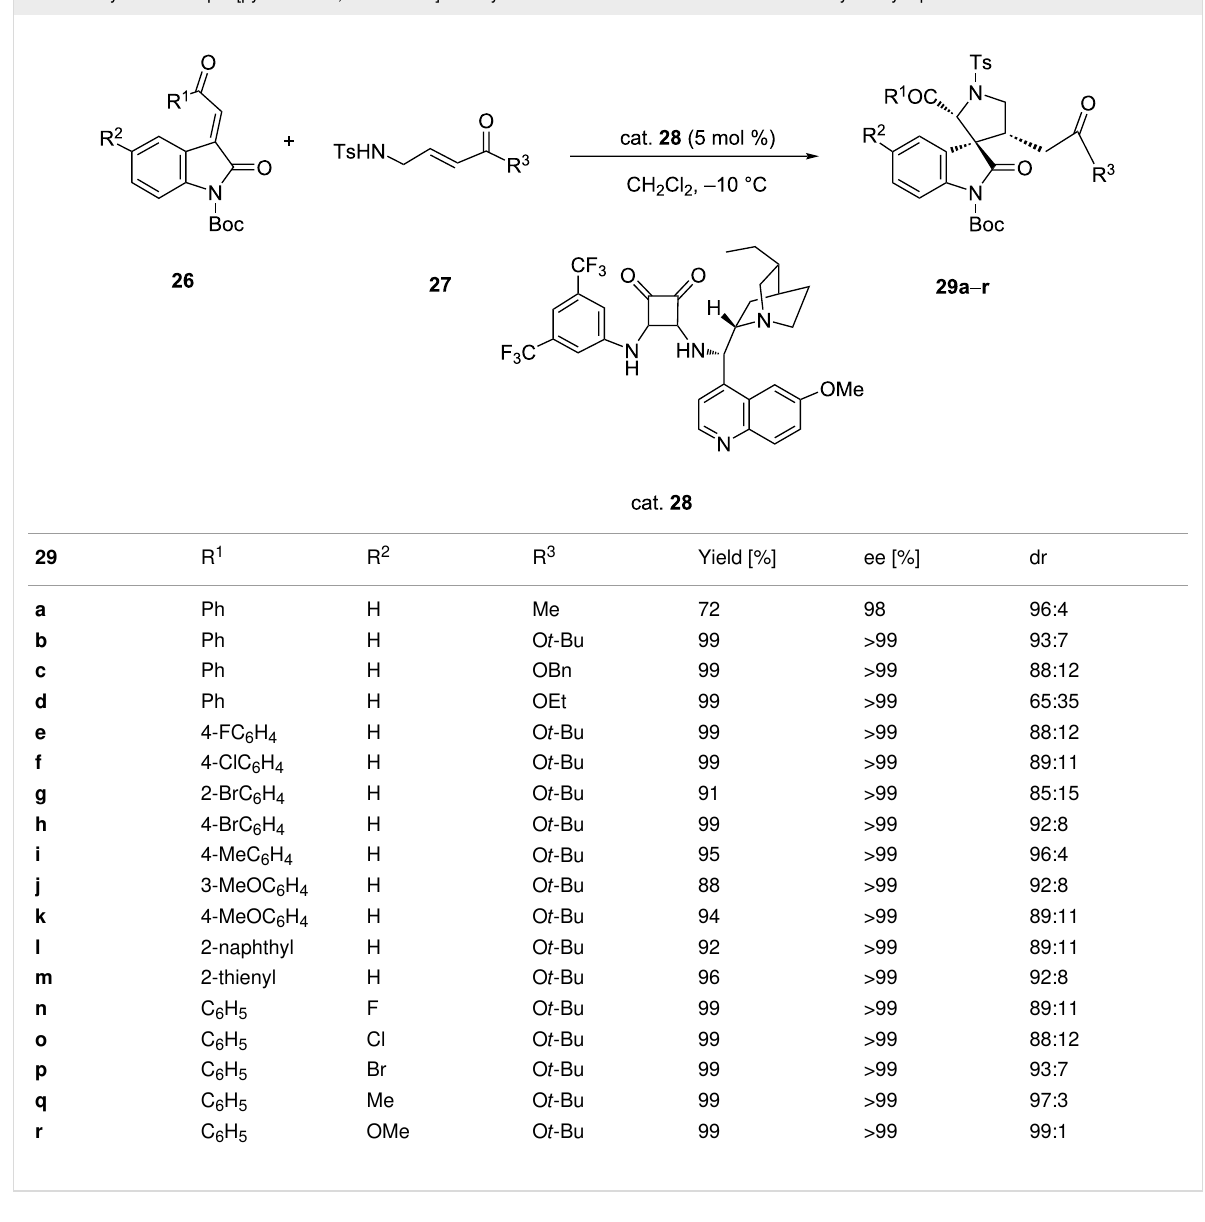
Table 6: Synthesis of spiro[pyrrolidine-3,3'-oxindoles] via asymmetric cascade aza-Michael reaction catalyzed by